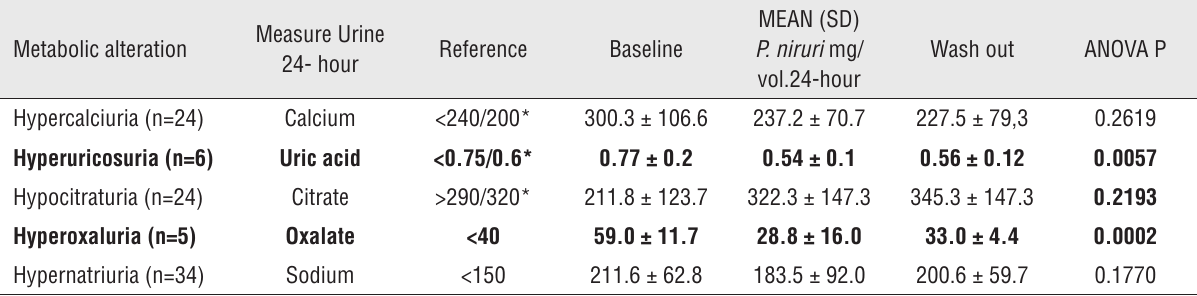
Table 2 - Metabolic alterations in 24-hour period urine at baseline and when taking P. niruri and wash out.